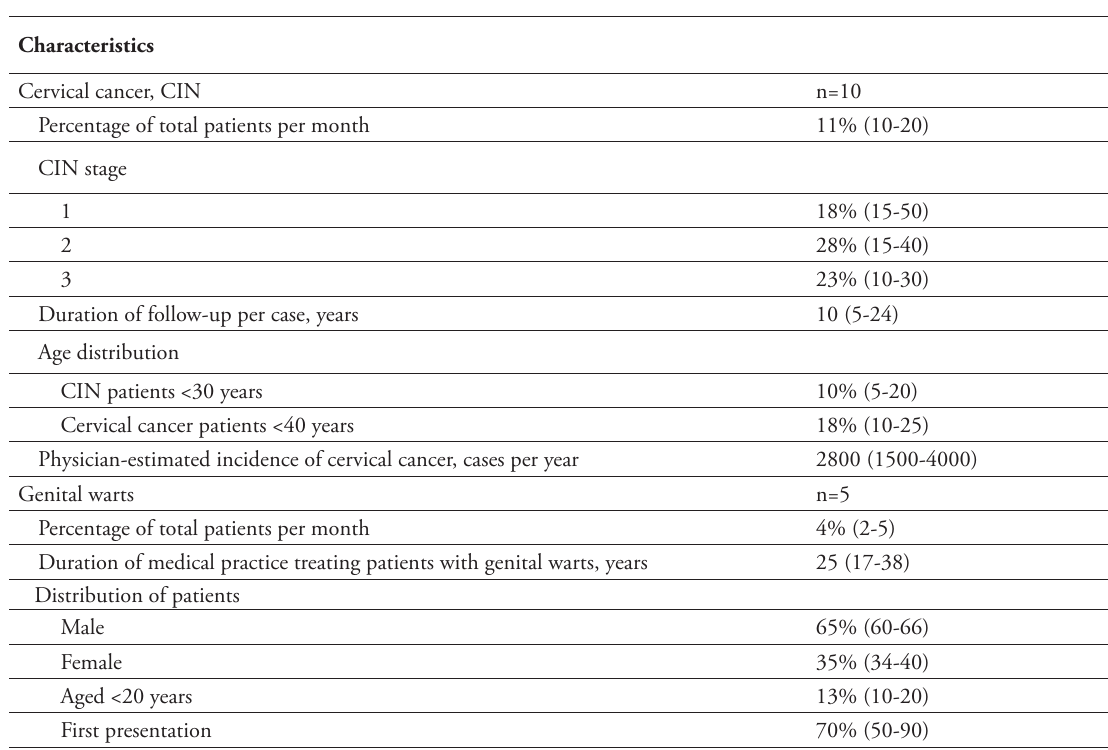
Table 1. Practice Characteristics a